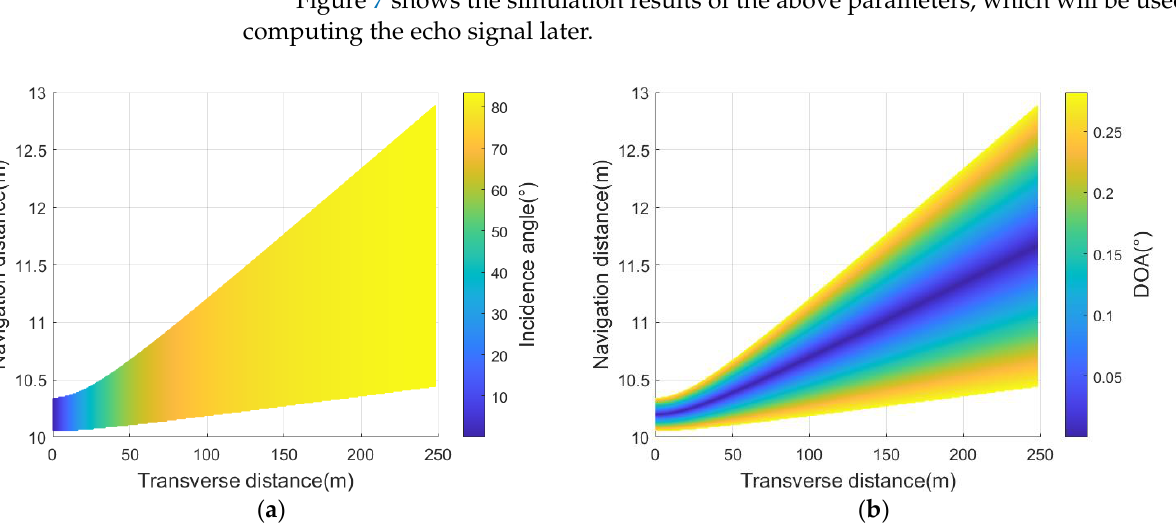
Figure 6. ( a ) A virtual seabed with 5 parallel harmonic curve targets; ( b ) the inaccurate receiving beam footprint of stop&hop path model; ( c ) the accurate receiving beam footprint of polyline path model; ( d ) acoustic propagation distance in the receiving beam footprint.